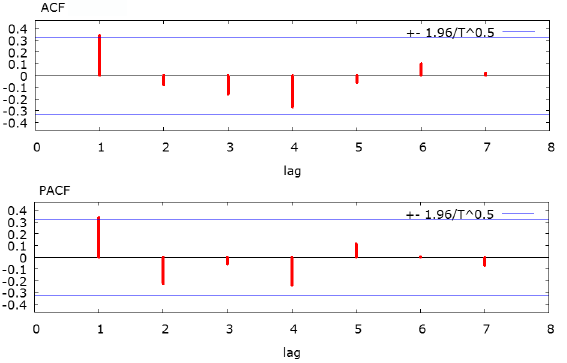
Fig 4. Correlogram for the first differences of the log-transformed Gini index series. ACF: autocorrelation function; PACF: partial autocorrelation function.